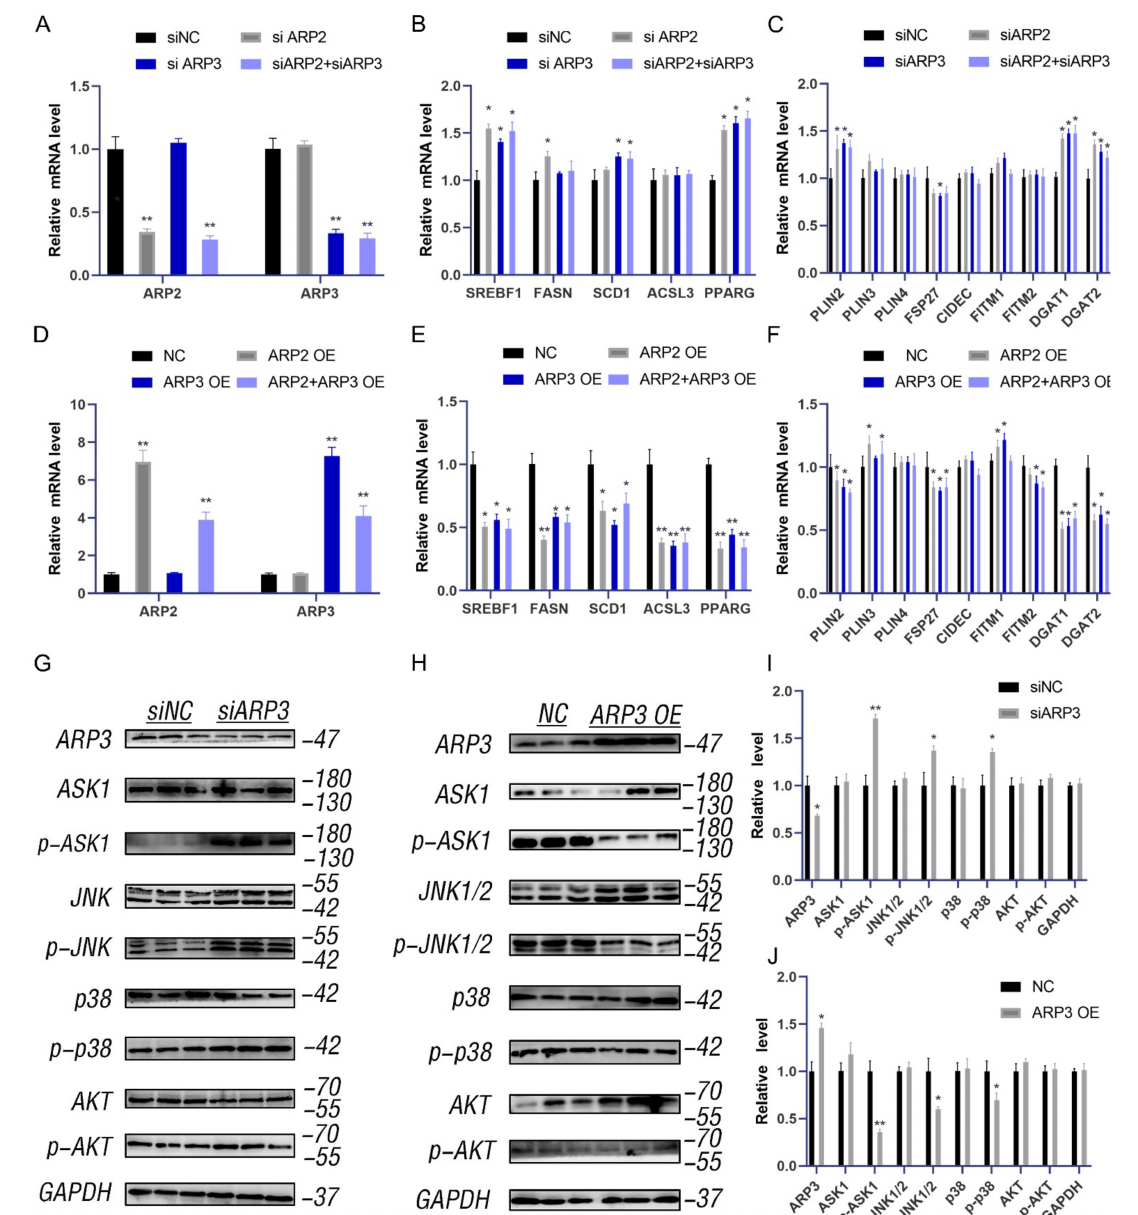
Figure 2. ARP2 and ARP3 regulate the expression level of FA and lipid synthesis-related genes. ( A ) Interference efficiency detection by qRT-PCR. * p < 0.05, ** p < 0.01 ( B ) The expression level of fatty acid synthesis-related genes detected by qRT-PCR. * p < 0.05. ( C ) The expression level of lipid synthesis-related genes detected by qRT-PCR. * p < 0.05. ( D ) Overexpression efficiency detection by qRT-PCR. ** p < 0.01. ( E ) The expression level of fatty acid synthesis-related genes detected by qRT-PCR. * p < 0.05. ( F ) The expression level of lipid synthesis-related genes detected by qRT-PCR. * p < 0.05. ( G ) The ASK1-p38-JNK and AKT signaling in groups of interfered ARP3 and control cells as detected by Western Blot experiments. ( H ) The ASK1-p38-JNK and AKT signaling in the overexpression cell group and control cells as detected by Western Blot experiments. ( I ) A grey value analysis of G. ImageJ software (ImageJ 1.52a, NIH, Bethesda, MD, USA)was used for this analysis, according to the instructions. * p < 0.05, ** p < 0.01. ( J ) A grey value analysis of H. ImageJ software (ImageJ 1.52a, NIH, Bethesda, MD, USA)was used for this analysis, according to the instructions. * p < 0.05, ** p <